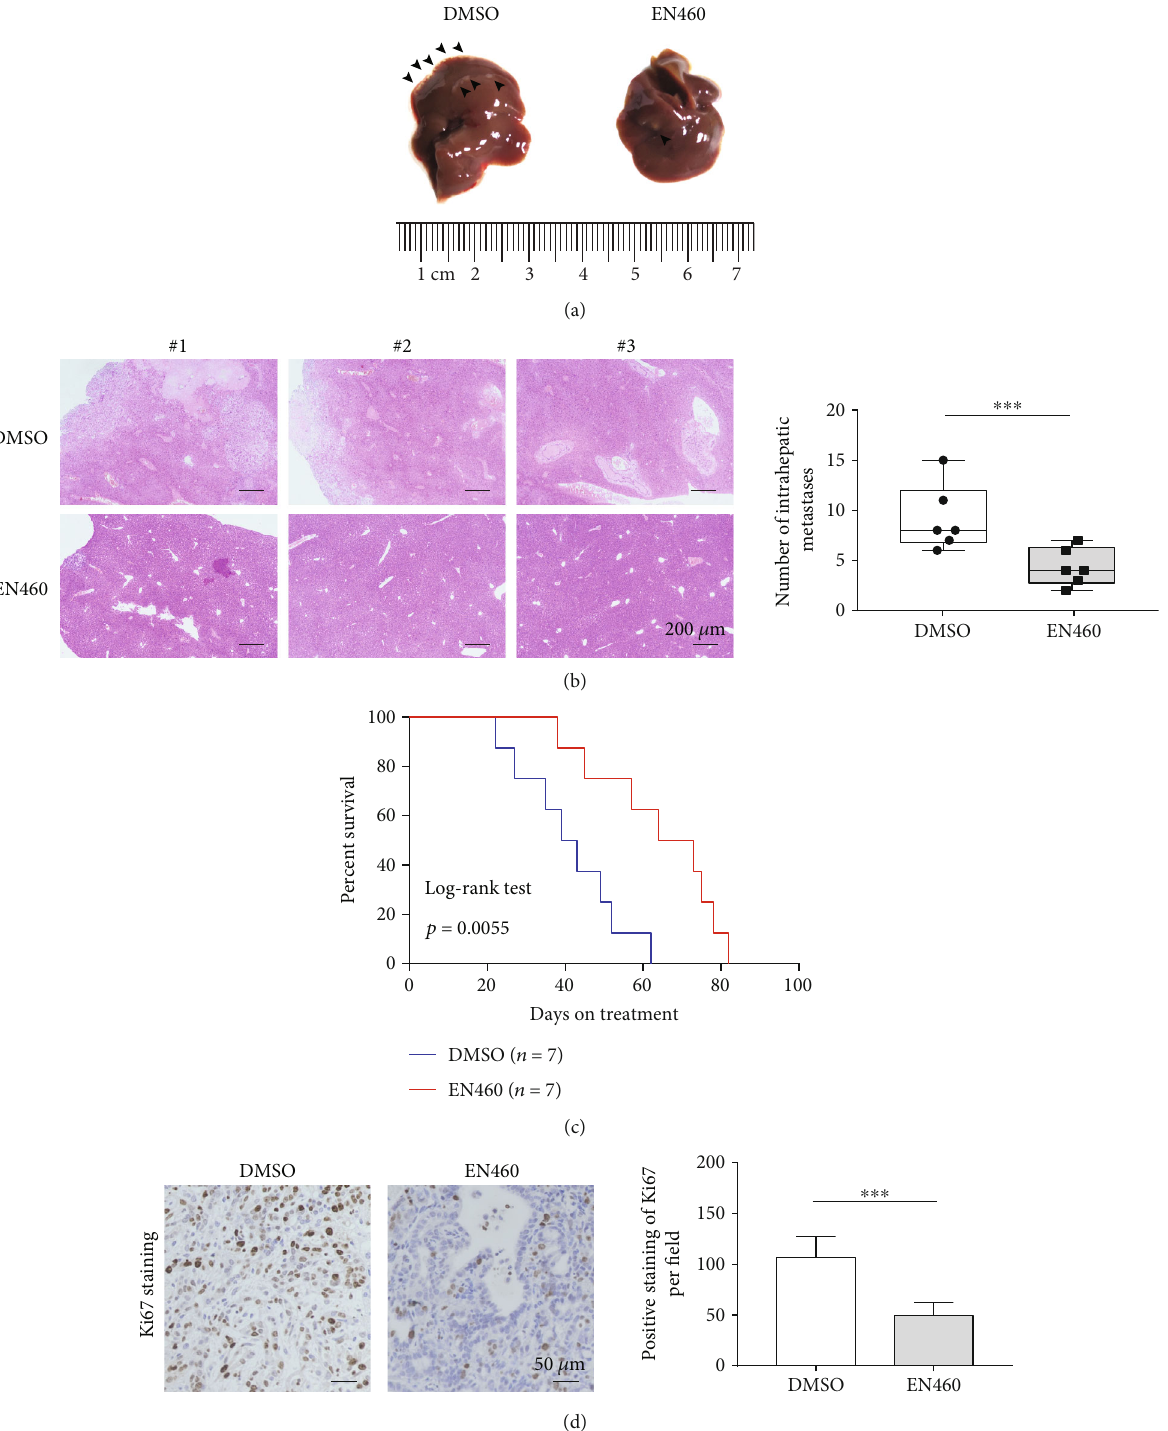
Figure 4: Pharmacological inhibition of ERO1L suppresses hepatic metastasis in vivo. a, b In vivo growth assay suggesting that ERO1L inhibitor, EN460 signi fi cantly decreased the number of liver nodules from Panc02 cell transplanted mice. Gross xenograft (a) and HE- staining images (b) were shown. (c) Kaplan-Meier survival curves showing the survival time of Panc02 PDAC cell transplanted mice treated with/without EN460 (log-rank test, P = 0 : 005 ). (d) Representative immunohistochemistry images showing EN460 suppressed liver nodules growth of PDAC in vivo. Scale bar: 50 μ